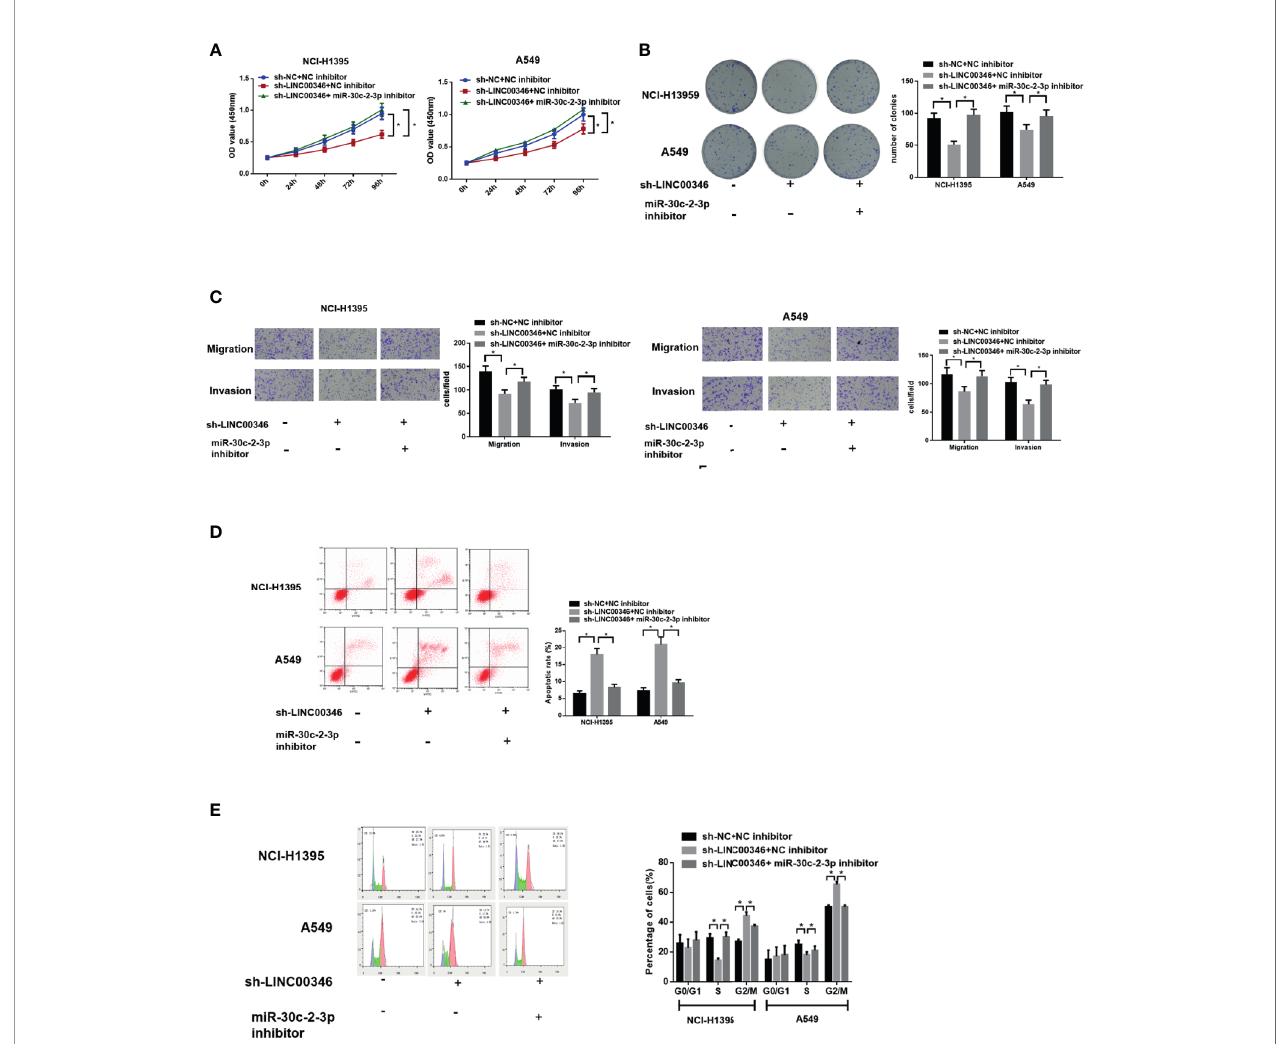
FIGURE 4 | Inhibition of miR-30c-2-3p reverses the effects of LINC00346 knockdown on LUAD cells. Cell proliferation (A) , colony formation ability (B) , migration and invasion (C) , apoptosis and cell cycle distribution (D, E) of each group were analyzed by CCK-8, colony formation, Transwell and FCM assays, respectively. * P <